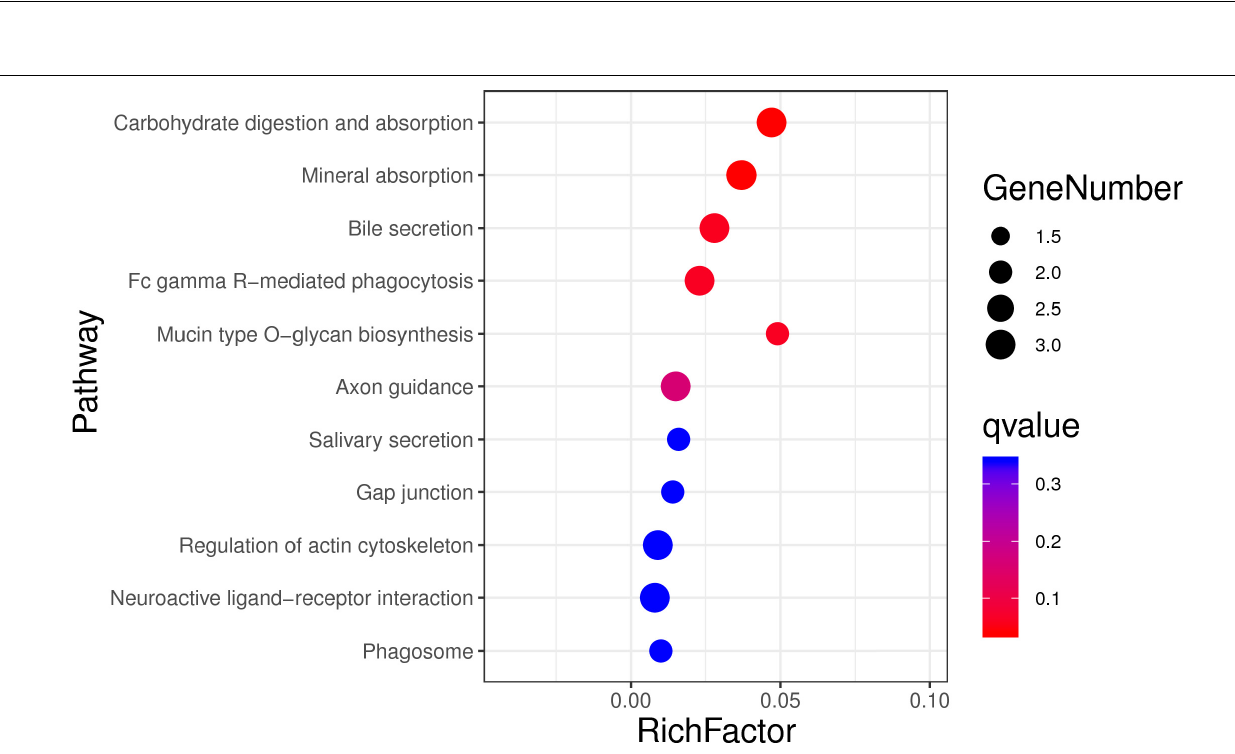
FIGURE 6 | Top 20 enrichment pathways, the size of dot refers to the number genes related to pathway, and the red to blue indicate the significant q -value change.